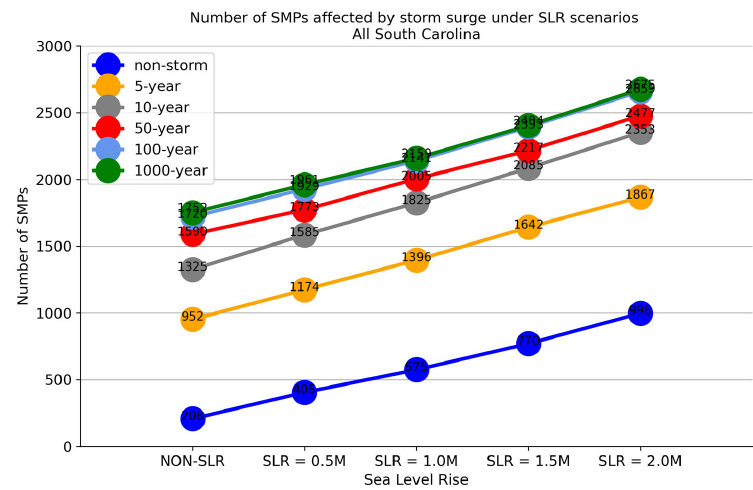
Figure 11. The number of SMPs in the entire coast of South Carolina that are at risk of storm surge heights with 0-year (non-storm), 5-year, 10-year, 50-year, 100-year and 1000-year return periods under scenarios of 0 m, 0.5 m, 1.0 m, 1.5 m, and 2.0 m SLR. Under the worst ‐ case scenario, 2600 SMPs could be inundated if a local 1000 ‐ year TC storm surge coincides with a high tide under an SLR of 2 m, or 12% of all SMPs in South Carolina, according to the 2014 survey (Cotti ‐ Rausch et al., 2018).